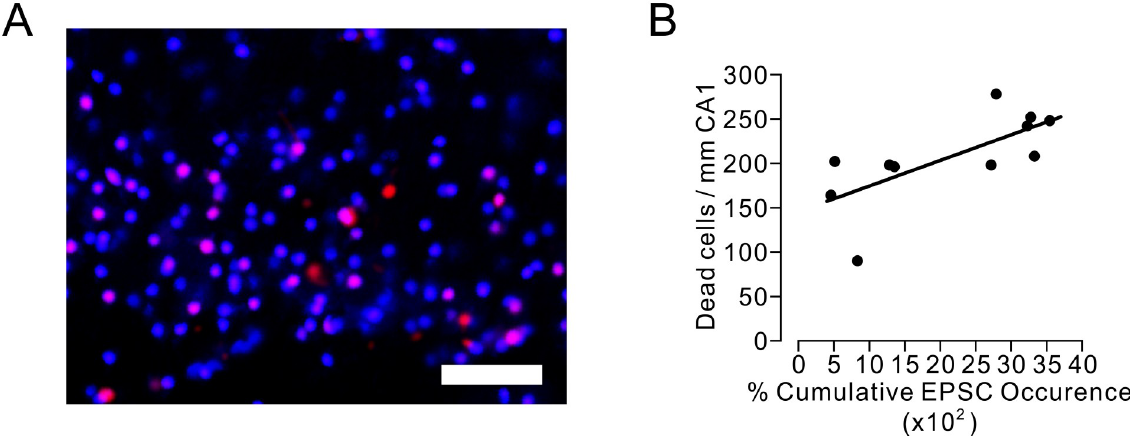
Fig 2. Correlation between cumulative EPSC occurrence and the number of cells died due to ischemic insult in hippocampal CA1 area. A. Microscopic images of CA1 area showing nuclei of dead cells. Magenta-colored cells stained with both propidium iodide and SYTOX-blue were considered to have died before electrophysiological recording. Blue-colored cells stained with only SYTOX-blue were assumed to have died due to ischemia-reperfusion injury. Scale bars = 50 μ m. B. Two-dimensional scatter plot of cumulative EPSC occurrence and dead cell number per 1 mm of CA1 area. A positive correlation between cumulative EPSC occurrence and surviving cell number was statistically significant (Pearson’s correlation coefficient r = 0.70, n = 11, Student’s t = 2.96, p = 0.016). The line represents an estimated linear regression.